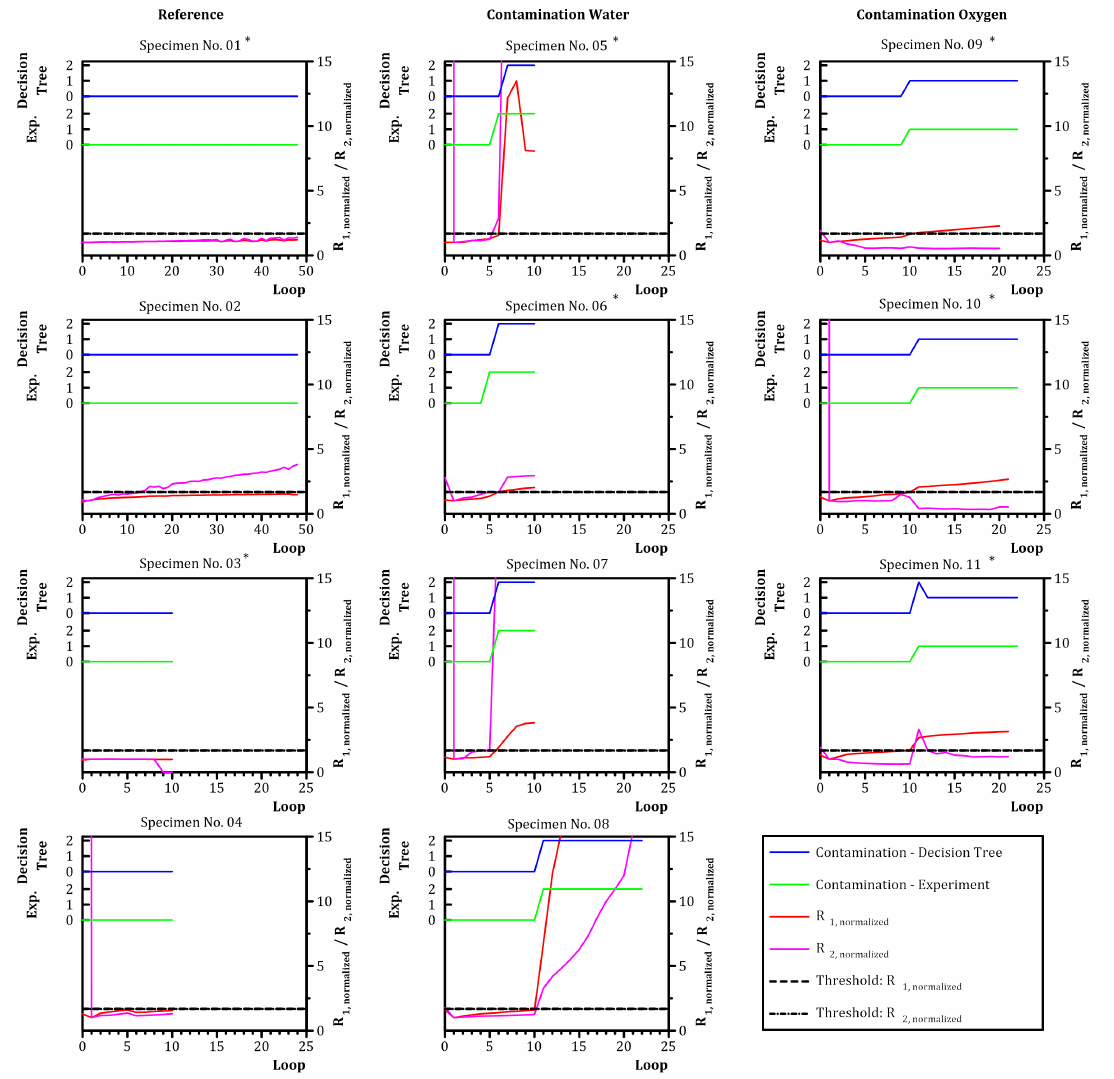
Figure 9. Prediction of classes “no contamination” (0), “contamination—oxygen” (1) and “contamination—water” (2) with a decision tree of a depth of two based on R 1, normalized , CPE 1, normalized − P and R 2, normalized . Blue—decision tree. Green—experiment. * Training data—data set was used as training data for the decision